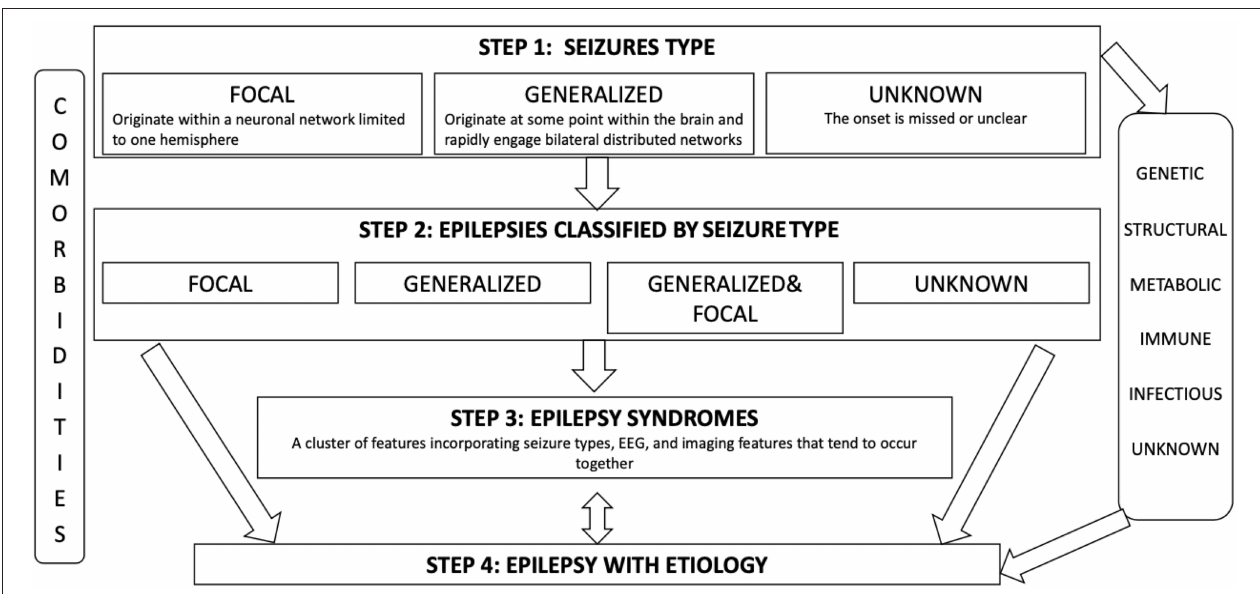
FIGURE 1 | Framework for epilepsy classification designed to allow diagnosis at multiple levels depending on the informationand resources available. At all levels of diagnosis, we should consider more broadly the etiology of the patient’s epilepsy. A range of six etiological groups has been recognized: genetic, structural, metabolic, immune, infectious, and